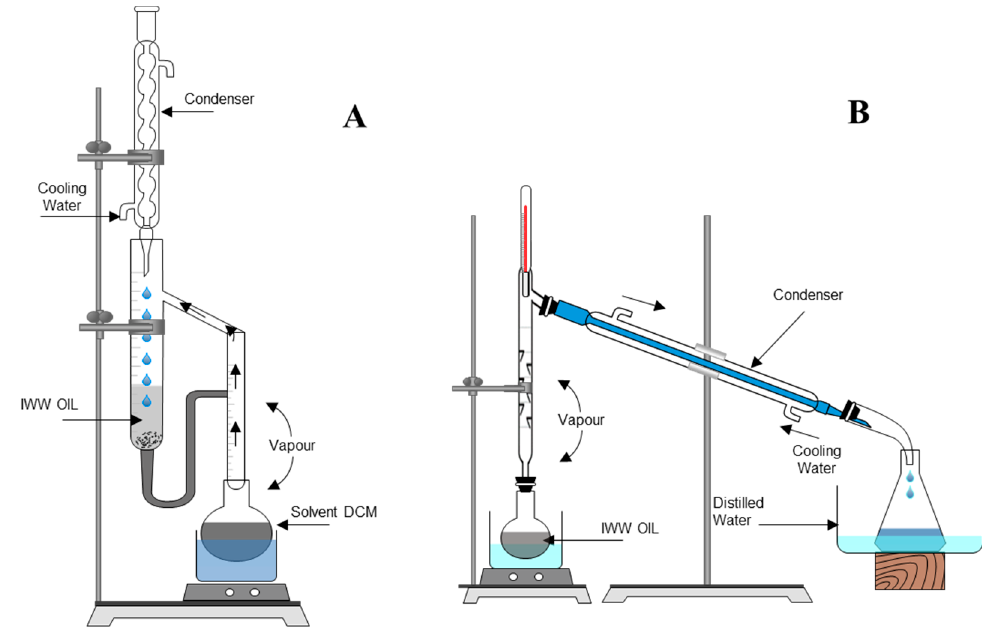
Figure 1. ( A ) Laboratory assembly used for the continuous liquid–liquid extraction with dichloromethane (CLLE DCM ) and ( B ) high-power fractional distillation (HPFD) of the wastewater